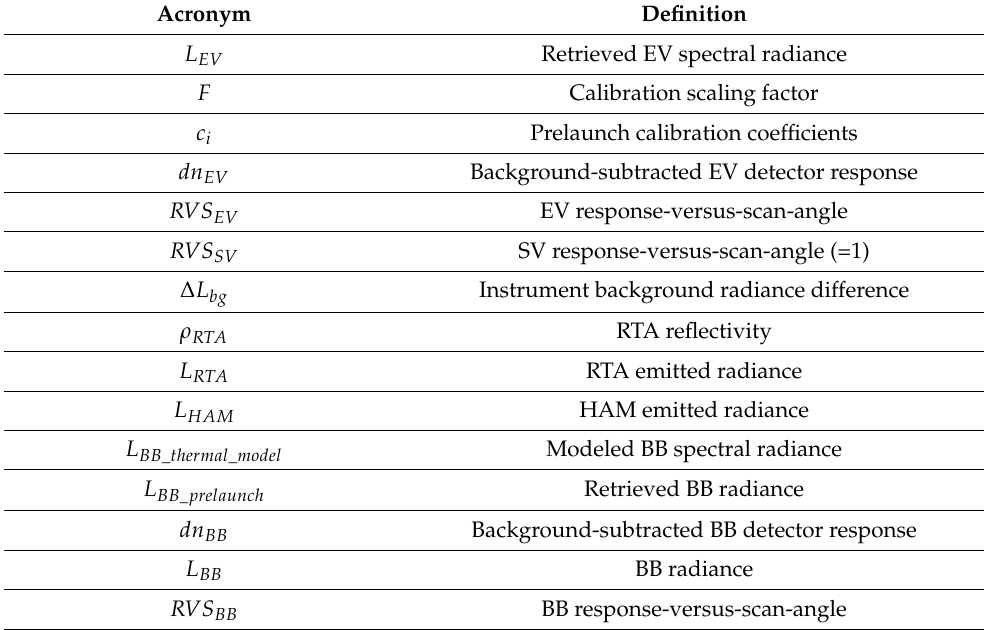
Table 3. VIIRS TEB calibration algorithm acronyms and definitions. Listed in order of appearance.